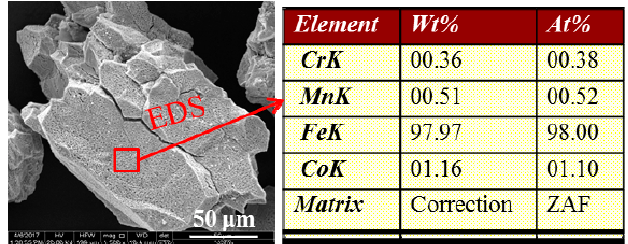
Figure 5. The EDS result of the particle surface after “blooming” happened.